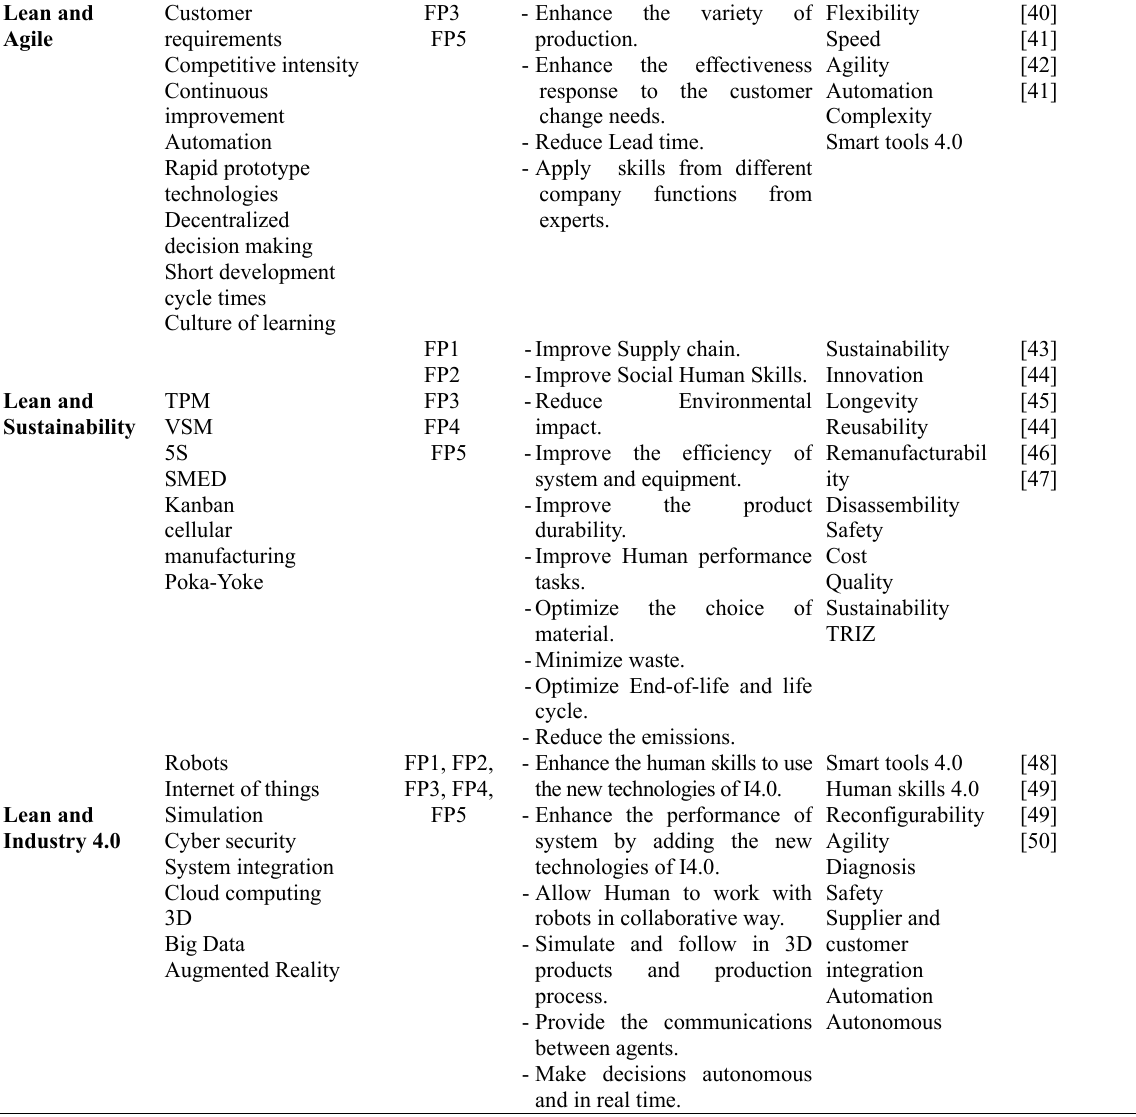
1) In step 1, as a classical design method, the de– signer defines all specifications demanded by the client. 2) In step 2, the designer provides a functional analysis to define technical functions, service functions, and constraints. 3) In step 3, the designer elaborates on a list of criteria regarding the objectives and the constraints. step 3, to the functionalities required by customers (technical functionalities).